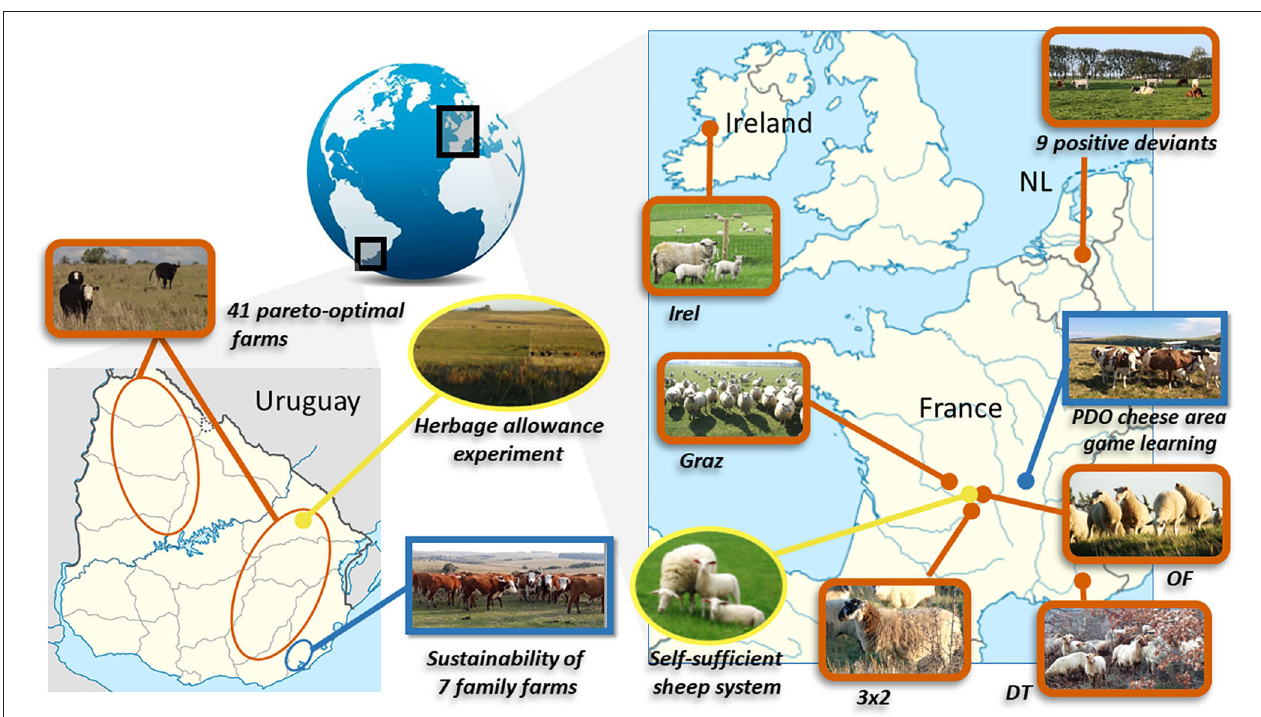
FIGURE 1 | Location of case studies. Brown rectangles are farms where trade-offs were analyzed, yellow ovals are long-term system experiments, and blue rectangles indicate a co-innovation